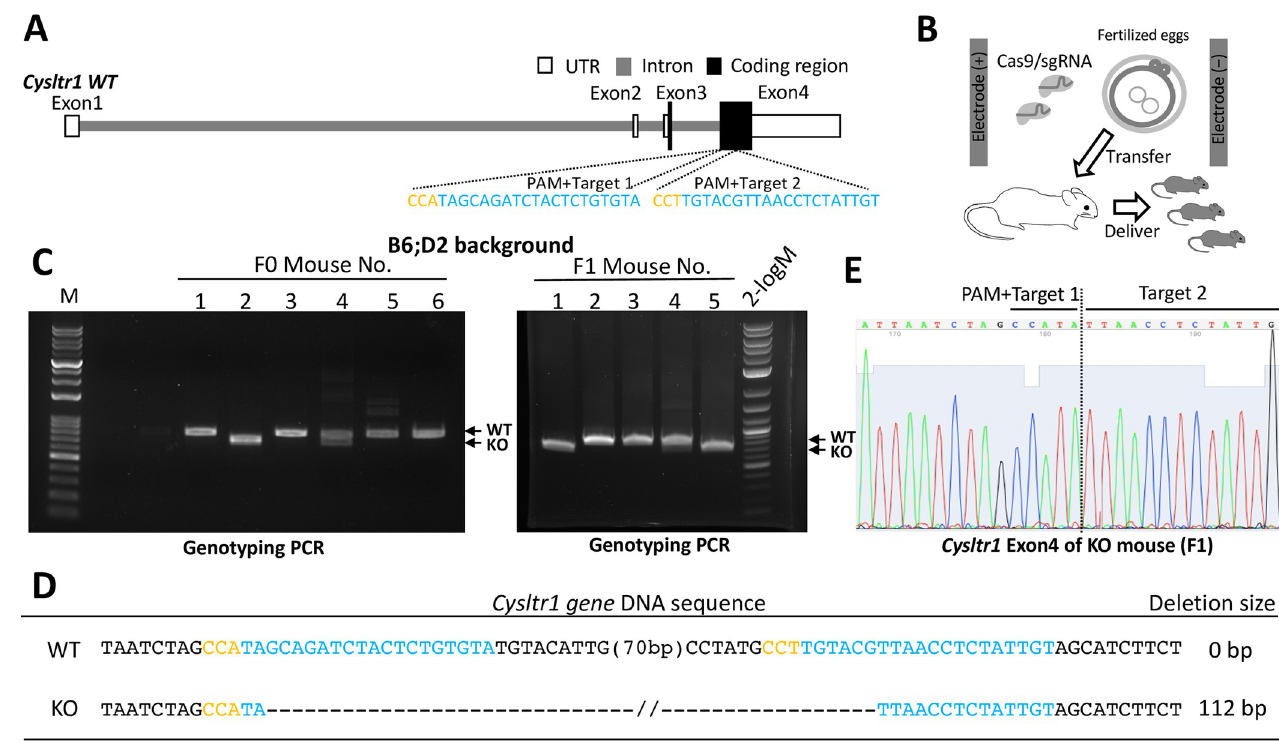
Fig 1. Cysltr1 gene knockout by the CRISPR-Cas9 system. (A) Schematic representation of the mouse Cysltr1 gene structure. Two sgRNA targeting sites were designed in exon 4. “PAM + Target 1 or 2” is a protospacer adjacent motif plus target sequences for the Cas9/sgRNA complex. (B) Schematic diagram of Cysltr1 knockout (KO) mouse generation using electroporation to transfer the Cas9/sgRNA complex into one-cell fertilized eggs from BDF1 mice. (C) Genotyping PCR of F0 (left) and F1 (right) pups after Cysltr1 gene editing in BDF1. The Cysltr1 wild-type (WT) amplicon size is 818 bp and the KO amplicon size is 706 bp. The F0 female mouse #4 was mated to a WT male mouse, providing the KO strain (F1 mice). (D, E) DNA sequences after Cysltr1 gene editing. (D) DNA sequences of target sites from WT and KO mice. The exact deletion size in the KO mouse was 112 bp. “-” indicates deleted nucleotide bases. (E) Sequencing